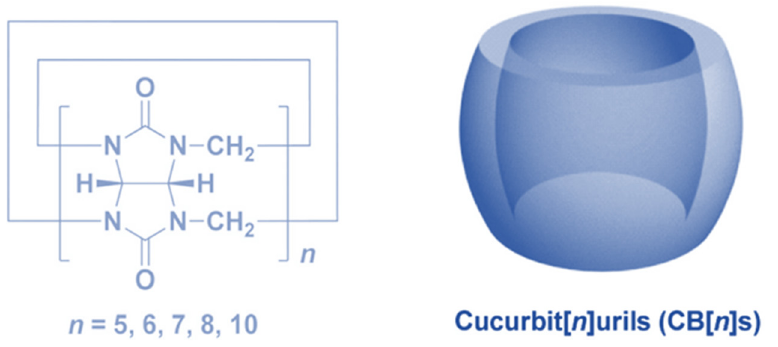
Figure 15. Chemical composition and cartoon representation of cucurbit[n]urils(CB[n]s) (reproduced with permission of Royal Society of Chemistry from ref. [21]).